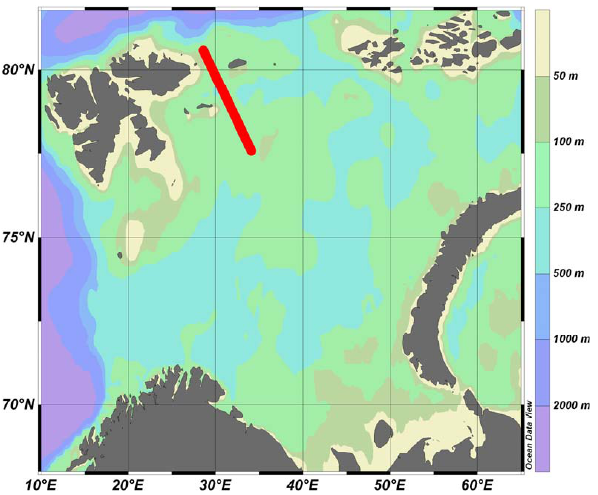
Figure 1. Area map with the cross-section (red strip) between the points 34.11  E., 77.57  N. Fig. 1. Area map with the cross-section (red strip) between the points 34.11 ◦ E, 77.57 ◦ N and 28.61 ◦ E, 80.58 ◦ N. and 28.61  E., 80.58  N.